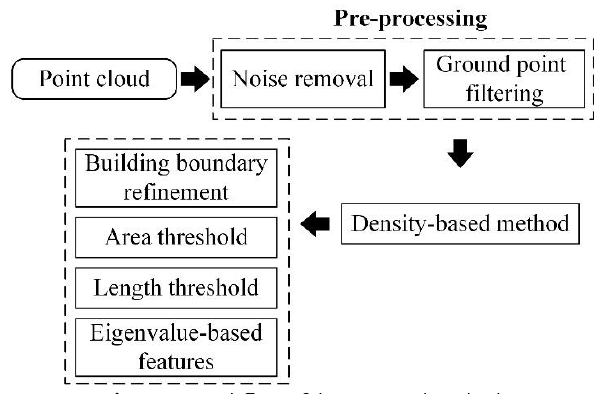
Figure 1 . Workflow of the proposed method.